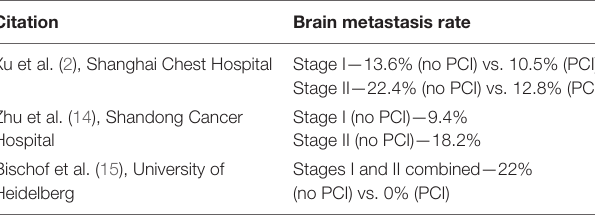
TABLe 1 | Brain metastasis rates reported in the literature for surgically resected early-stage small-cell lung cancer.